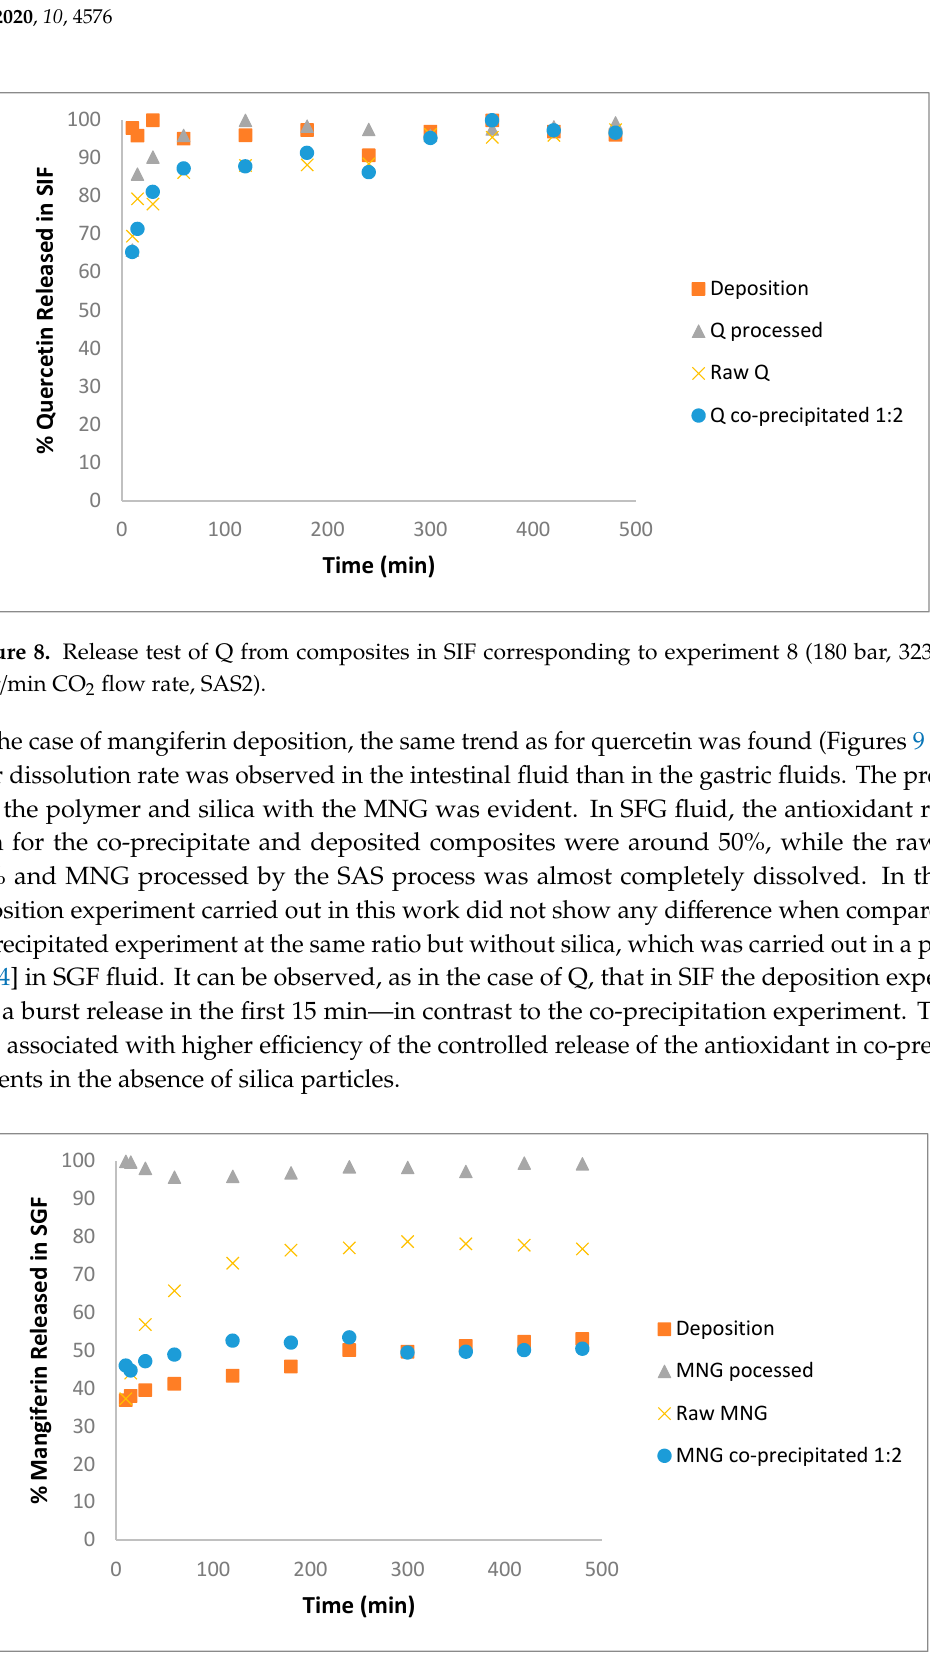
Figure 9. Release test of MNG from composites in SGF corresponding to experiment 6 (180 bar, 323 K, 30 g/min CO 2 flow rate, SAS1).